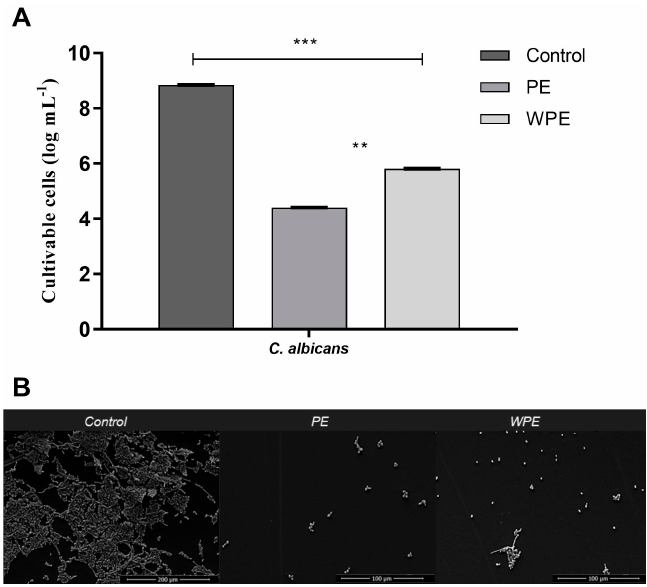
Figure 4. Effect of PE and WPE on seven-day preformed biofilm of C. albicans in flat-bottomed polystyrene microplates. Biofilms were treated for 24 h with PE and WPE at twice the minimum inhibitory concentration (MIC) which were 3425 µ g/mL and 275 µ g/mL of total phenol content (TPC), respectively. ( A ) Evaluation of cell viability by counting CFU. Statistical difference between: PE and WPE at p < 0.01 (**), and untreated control and treated biofilm at p < 0.001 (***). ( B ) SEM images of untreated (control) biofilms (magnification of 500; scale bar = 200 µ M) and biofilms treated with PE and WPE (magnification of 1000; scale bar = 100 µ